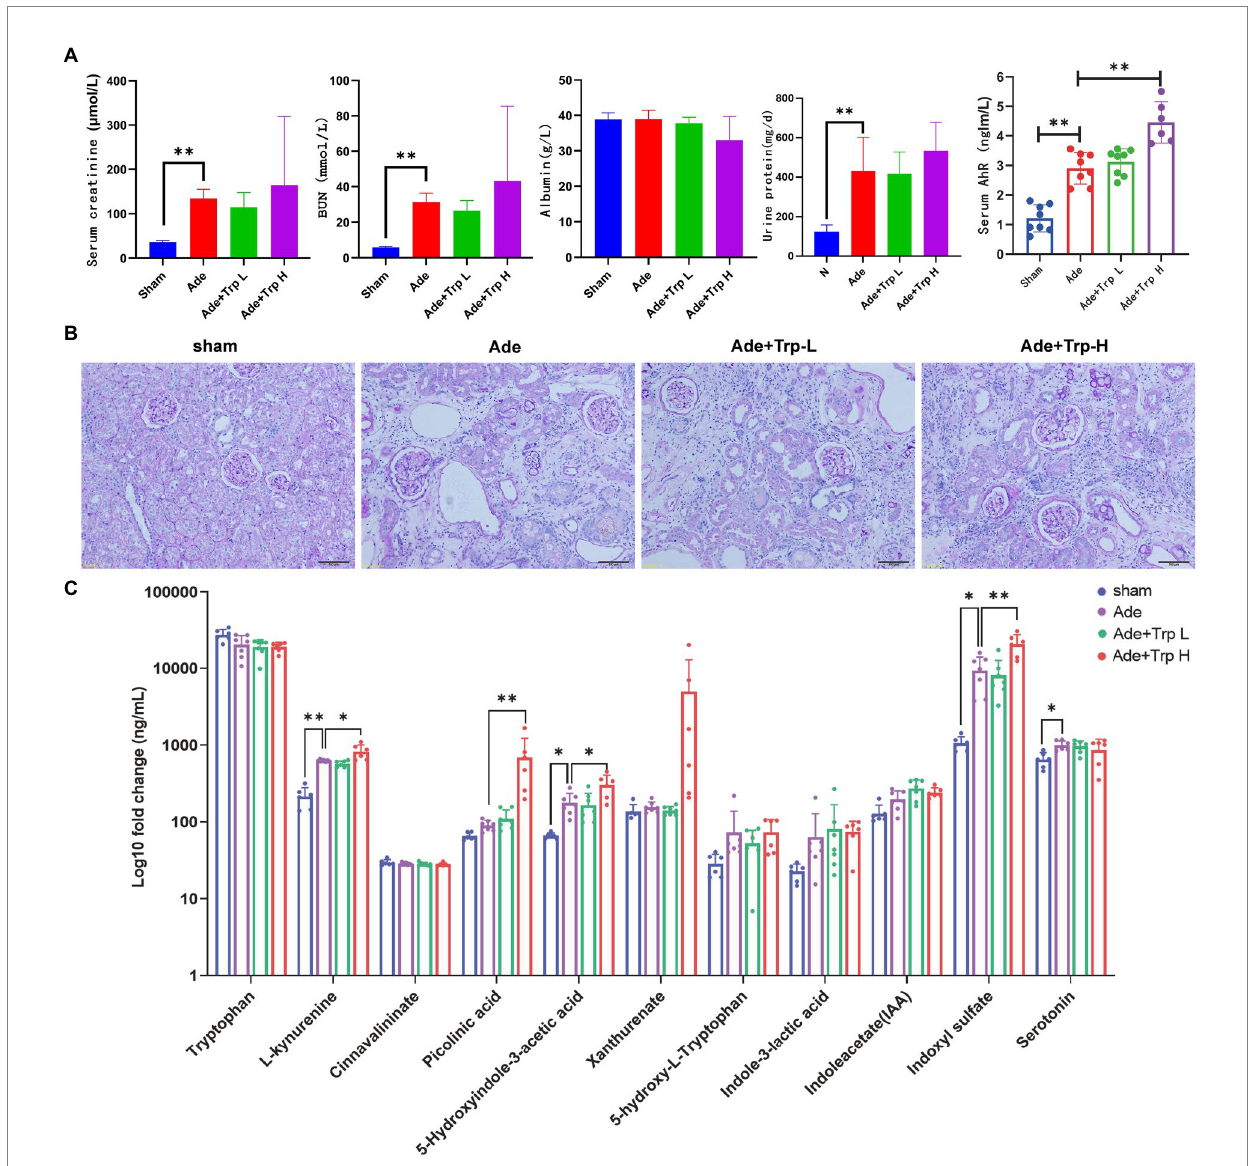
FIGURE 4 Tryptophan induced Kyn/IS accumulation and AhR pathway activation in CKD rats. (A) Serum creatinine, blood urea nitrogen, albumin, urine protein and AhR. (B) Periodic acid–Schiff (PAS) staining of kidney tissue (100×). (C) The levels of tryptophan metabolites in serum ( n = 6 in sham and Ade + Trp-H group, n = 7 in Ade and Ade + Trp-L group). The data are presented as the means + standard deviation (** p <